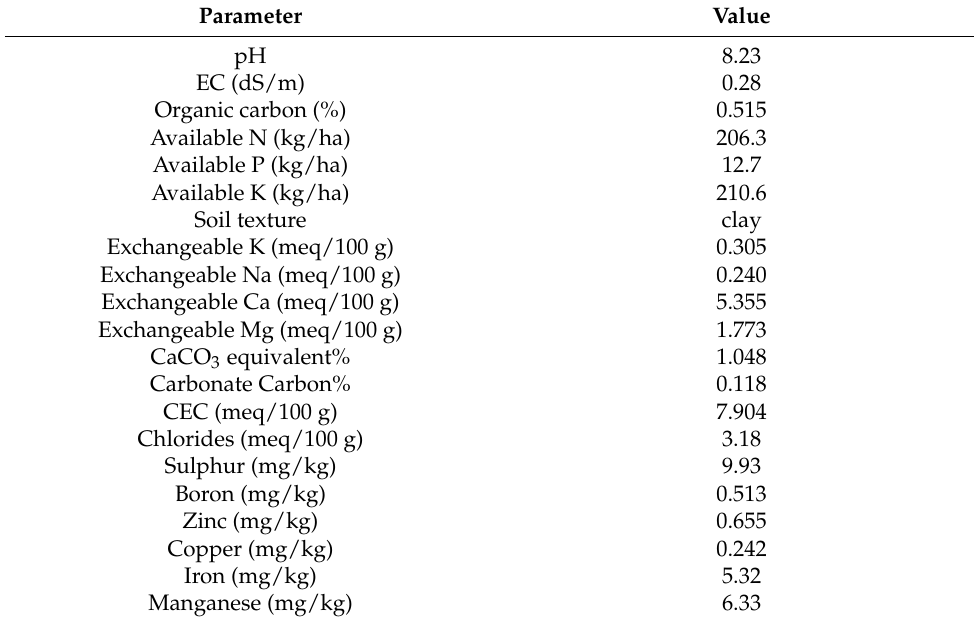
Table 1. Initial soil parameters of the experimental